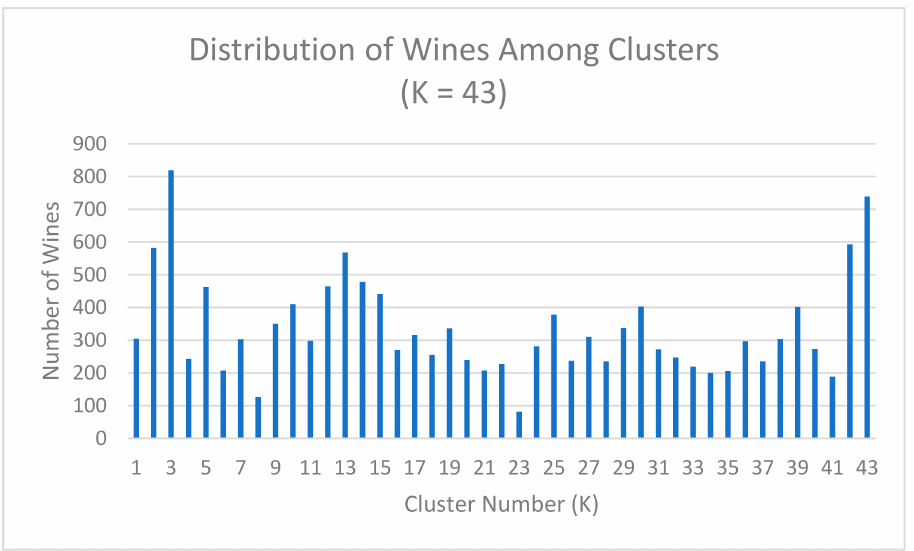
Figure 7. Wines present in each cluster (K) with the optimum K value. For every cluster label (K), the total number of wines present in the cluster are shown. The groups shown reflect the distribution of similar wines across 43 different